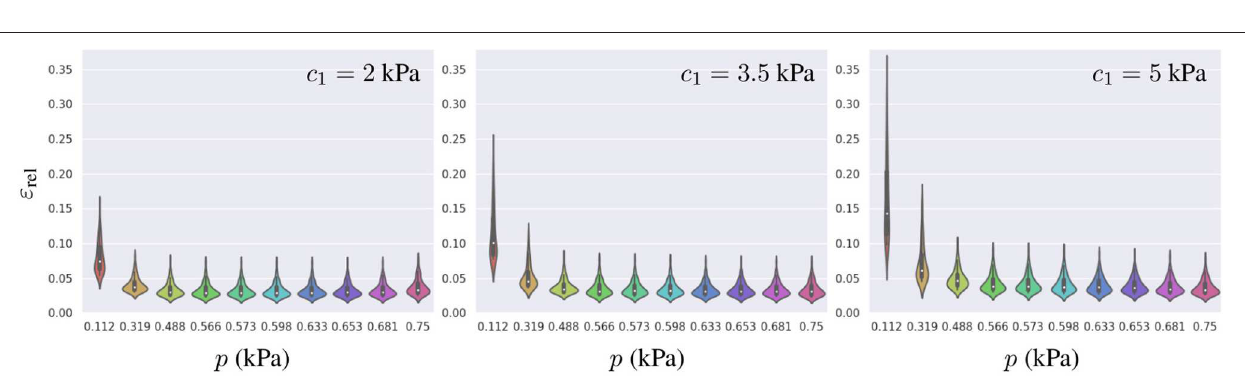
FIGURE 7 | Distribution of ε rel for the best-ranked surrogate model across all 81 geometries generated (training and testing datasets combined) leading to 81 samples per violin. From left to right, the error is presented for three different material properties c 1